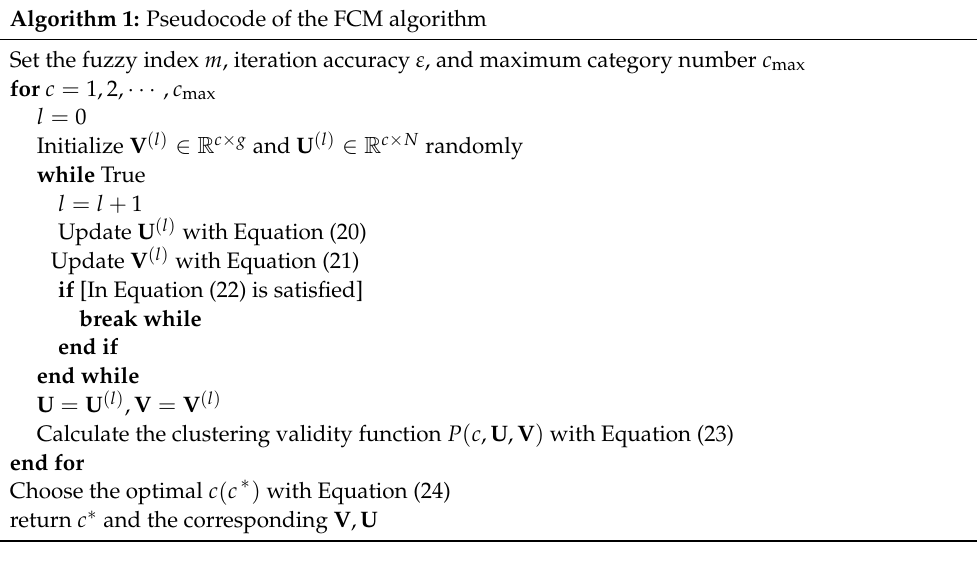
Algorithm 1: Pseudocode of the FCM